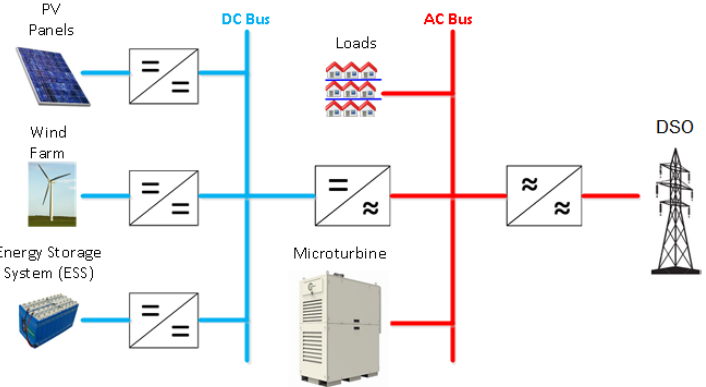
µ GridLab microgrid (MG) Figure 2. μGridLab microgrid (MG) diagram. Figure 2.